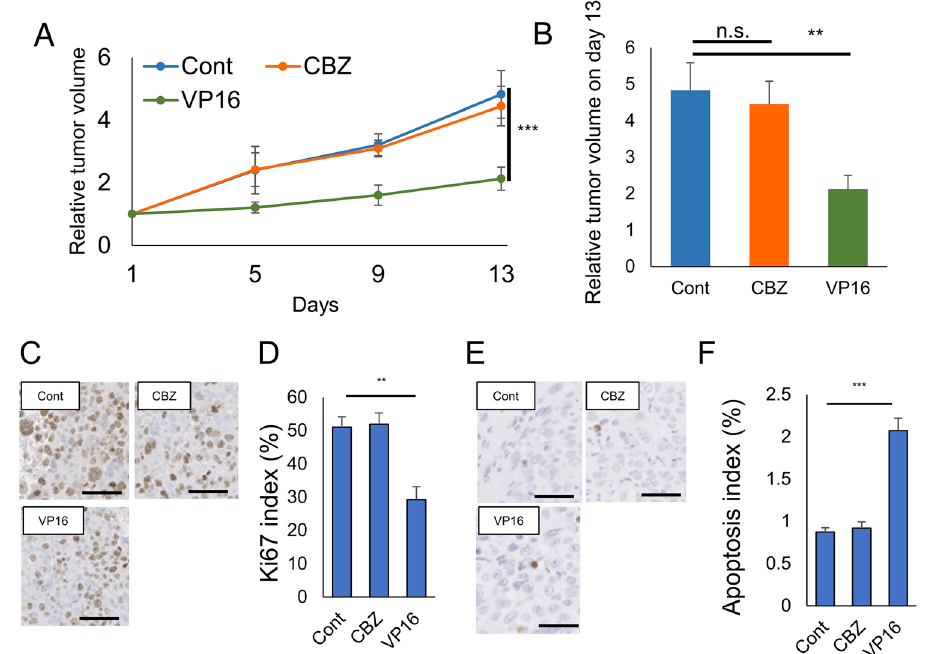
Figure 3. Efficacy of etoposide (VP16) in vivo. ( A ) Tumor growth over time for PC3CR xenograft tumors in castrated male nude mice during exposure to 10 mg/kg cabazitaxel (CBZ), 20 mg/kg VP16, or no treatment (Cont). ( B ) Relative tumor volume on day 13 in PC3CR xenograft tumors. ( C ) Immunohistochemical staining for Ki67 in PC3CR xenograft tumors. Bar indicates 100 µm. ( D ) Significant decrease in the Ki67 index was observed in the VP16 administration group compared with that in the control group. ( E ) TUNEL staining in PC3CR xenograft tumors. Bar indicates 100 µm. ( F ) Significant increase in the apoptosis index was noted for VP16 administration group compared with the control